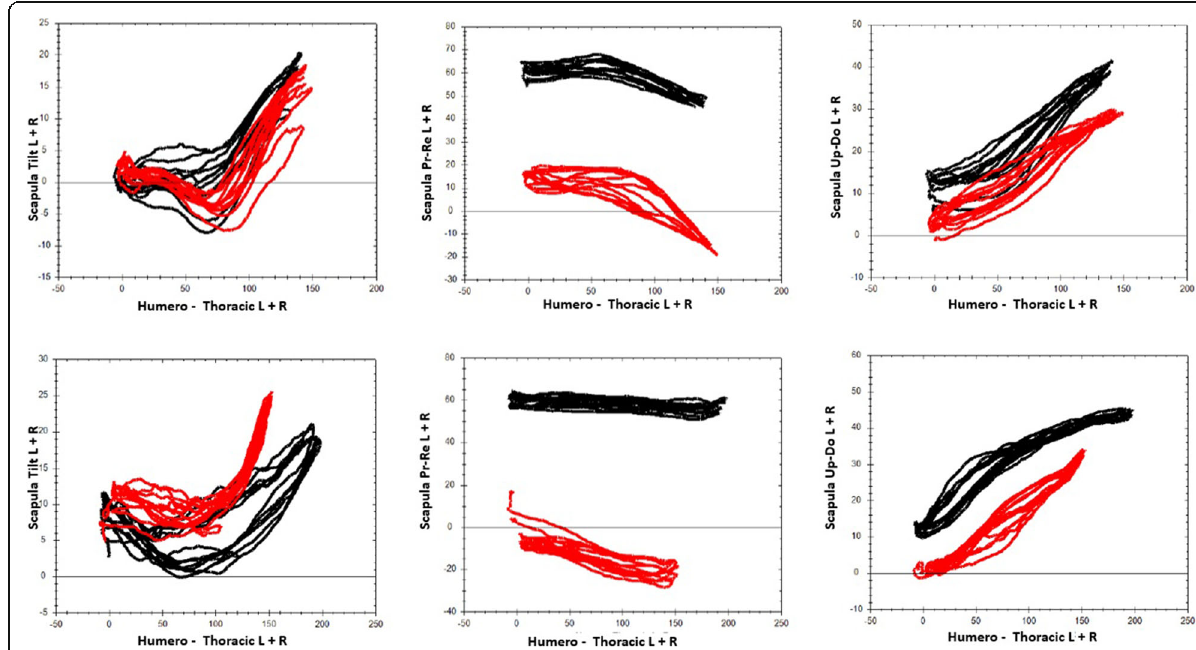
Fig. 3 the typical output from the system. A set of six graphs that pit the variations of the three scapular angles studied (upward/downward rotation [S-UpDo], internal/external rotation [S-PrRe] and anterior/posterior tilt [S-Tilt]) against the variations in total shoulder abduction (H-AbAd) or flexion (H-FlEx). The zig-zaging lines in the graphs represent the different repetitions for each movement. There are two lines in each graph representing both arms (red lines for left side, black lines for right side). In a normal evaluation, the examiner is able to see these six graphs live as they